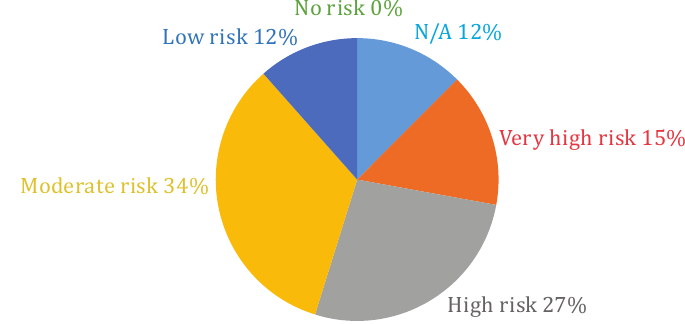
High risk 27% Figure 17. Rating of Wearing